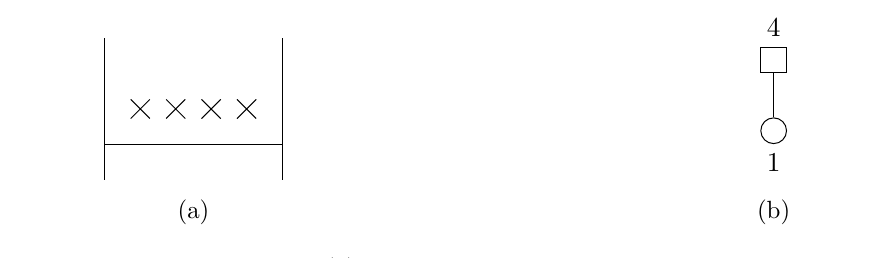
Figure 7. SQED with 4 (cid:13)avors. (a) is the local subsystem around one of the leftmost D3-branes in the Coulomb branch brane con(cid:12)guration of the quiver in (cid:12)gure 6. The corresponding moduli space is the A 3 Kleinian singularity, as indicated in table 1. (b) Corresponding